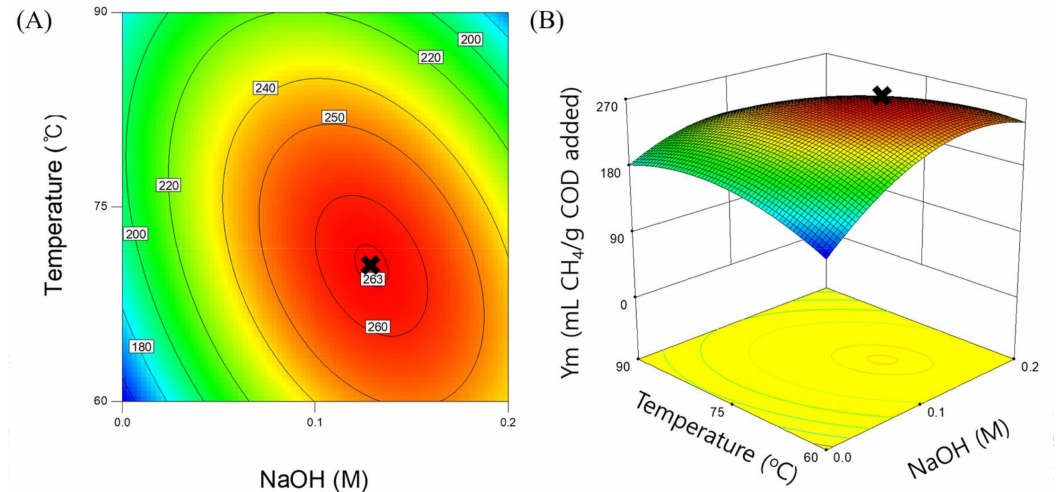
Figure 4. Two-dimensional ( A ) and three-dimensional ( B ) contour plots of the response surface for methane yield (Ym). The cross mark indicates the point of the maximum Ym